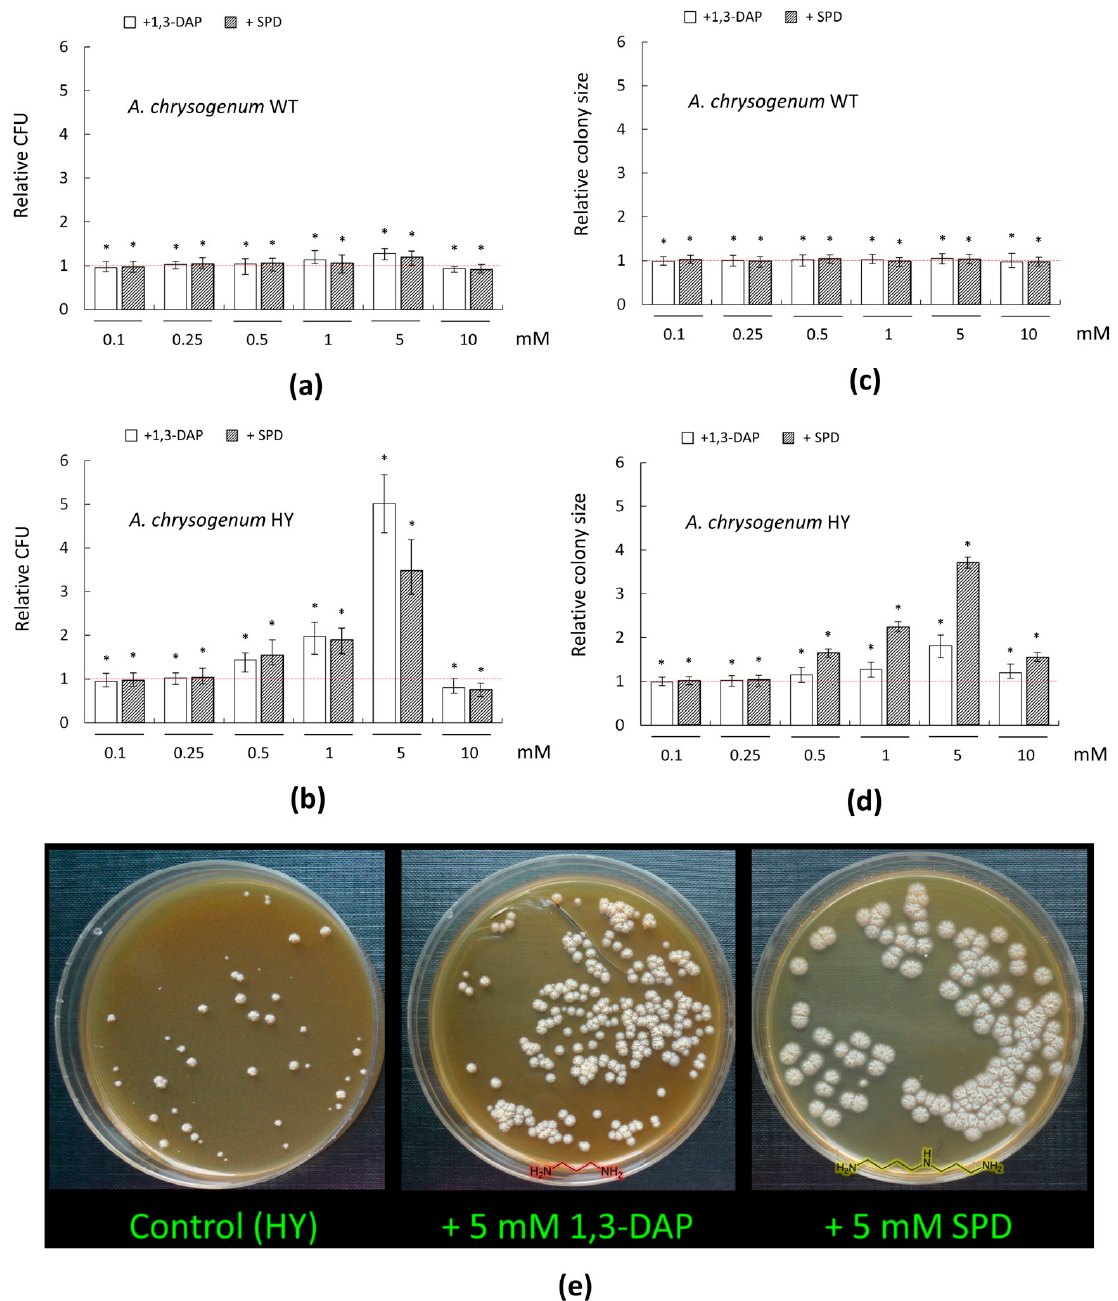
Figure 3. Effect of 1,3-diaminopropane (1,3-DAP) and spermidine (SPD) on the number and diameter size of germinating colonies of A. chrysogenum strains on agarized complex (CPA) medium: ( a , c ) A. chrysogenum wild type (WT) strain; ( b , d , e ) A. chrysogenum high-yielding (HY) strain. ( a , b ) Relative CFU (colony forming units)—the ratio of the of cell counts after incubation on CPA medium with PAs compared control counts (on CPA medium without any additions). ( c , d ) Relative size—the ratio of the average diameter of all colonies after inoculation on CPA with PAs compared to control’s average diameter of colonies (on CPA media without any additions). Dotted lines show the relative CFU level or colony diameter for strains inoculated on CPA without additives. Data are means ± SD, n = 3. Statistical significance, * p ≤ 0.05, as compared with the control (strain, cultivated on medium without PAs additions). ( e ) 12 days after inoculation of A. chrysogenum HY strain on CPA medium with the addition of 5 mM 1,3-DAP or 5 mM Spd, or without addition